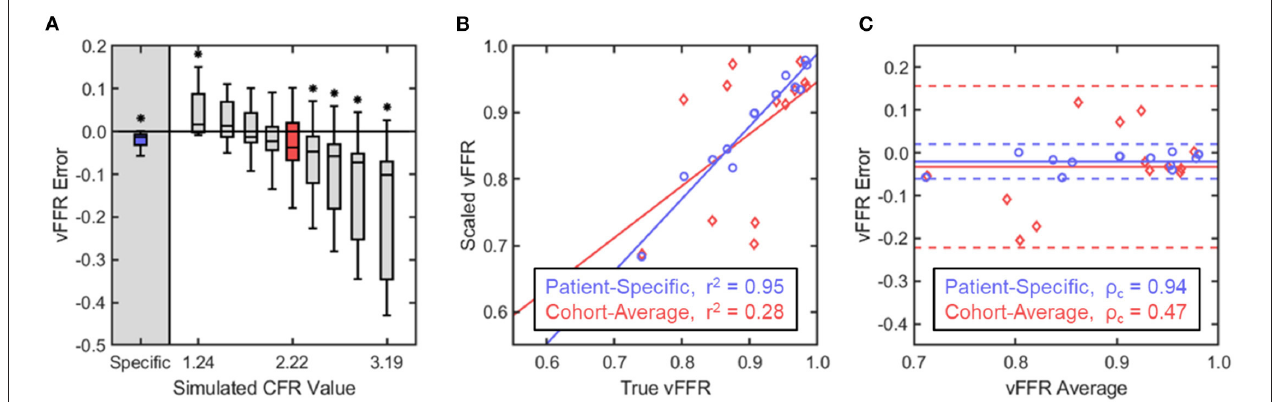
FIGURE 5 | Statistical analysis of vFFR estimation with variable flow conditions. (A) vFFR error was defined as the difference in the scaled vFFR value calculated with the basal waveform and the true vFFR value calculated with the hyperemic waveform. Within each group, the boxes represent the interquartile range and median while the whiskers indicate the 10 and 90th percentiles. Comparison within each simulated CFR group against the true vFFR was performed through a paired, two-way t -test, with significance determined for p < 0.05. (B) Scaled vFFR values were plotted against the corresponding true vFFR values for two CFR groups: (1) the patient-specific CFR values and (2) the cohort-average CFR value of 2.2. Linear regression determined a line of best-fit for each group, and Pearson’s correlation coefficient determined the linearity of the relationship. (C) A Bland–Altman analysis and calculation of Lin’s concordance correlation coefficient was performed to assess the concordance of the relationship. For each match-pair of true vFFR and scaled vFFR, the difference between the two values was plotted against their average. The solid lines indicate the mean vFFR error while the dashed lines indicate two standard deviations from the mean.